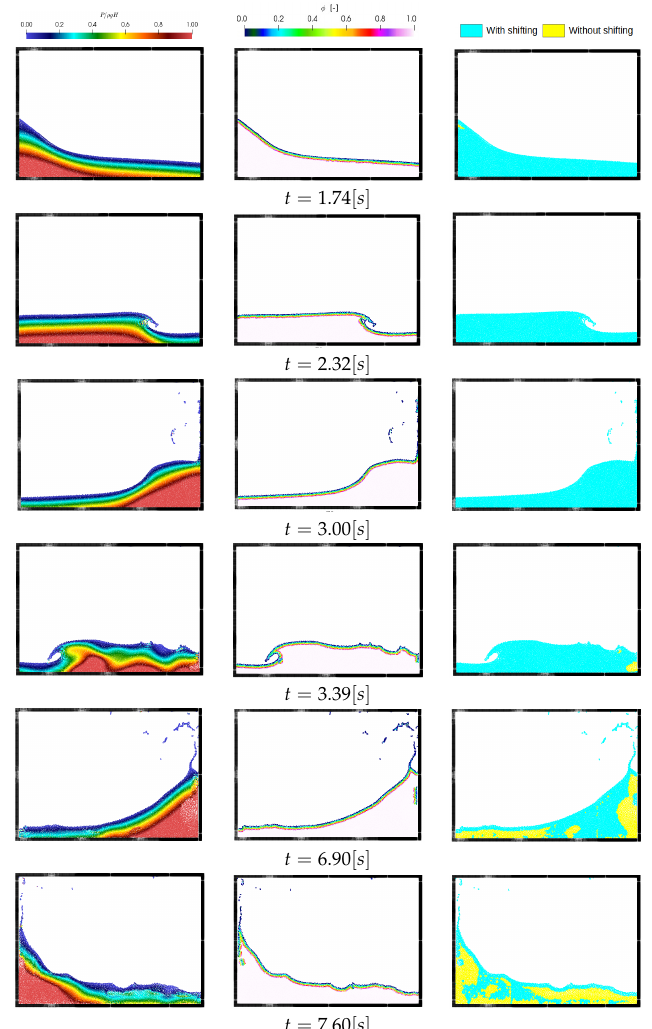
Figure 28. Sloshing in a rectangular tank: Snapshots of the computational results at times t = { 1.74,2.32,3.00,3.99,6.90,7.60 } s. The left column presents the pressure filed, the middle column denotes the φ -parameter filed and the right column presents the restriction field (no shifting is applied on the yellow